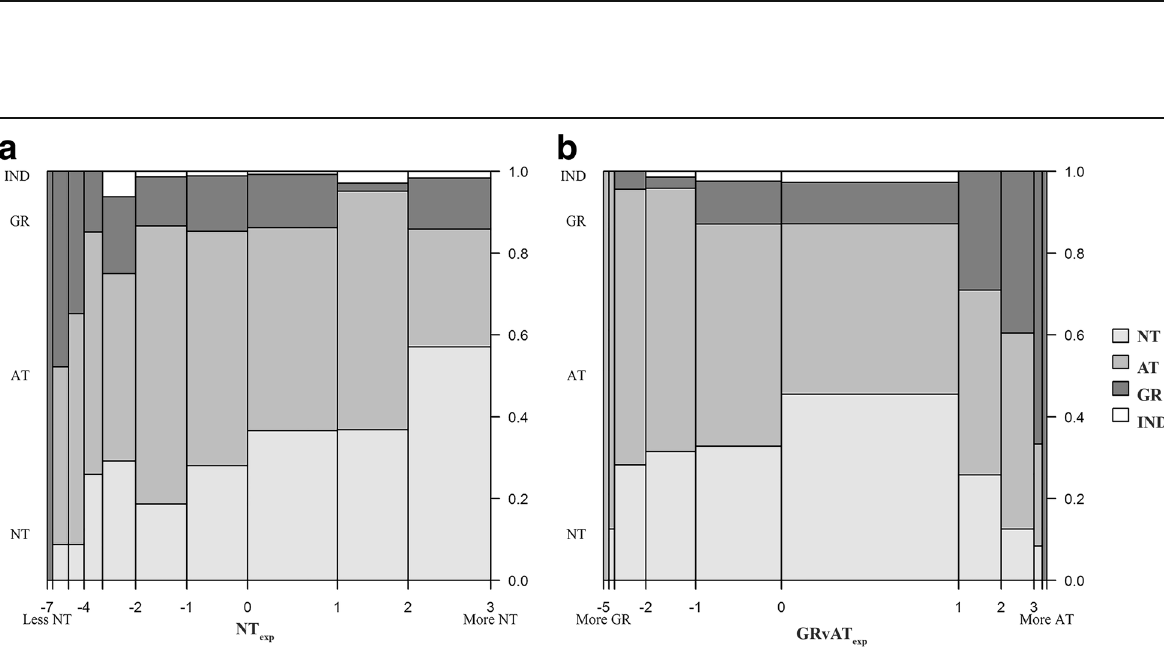
Fig. 3 Playing surface where the most serious injury was reported, expressed as a proportion ( Y -axis) relative to varying levels of a NT exp and b GRvAT exp ( X